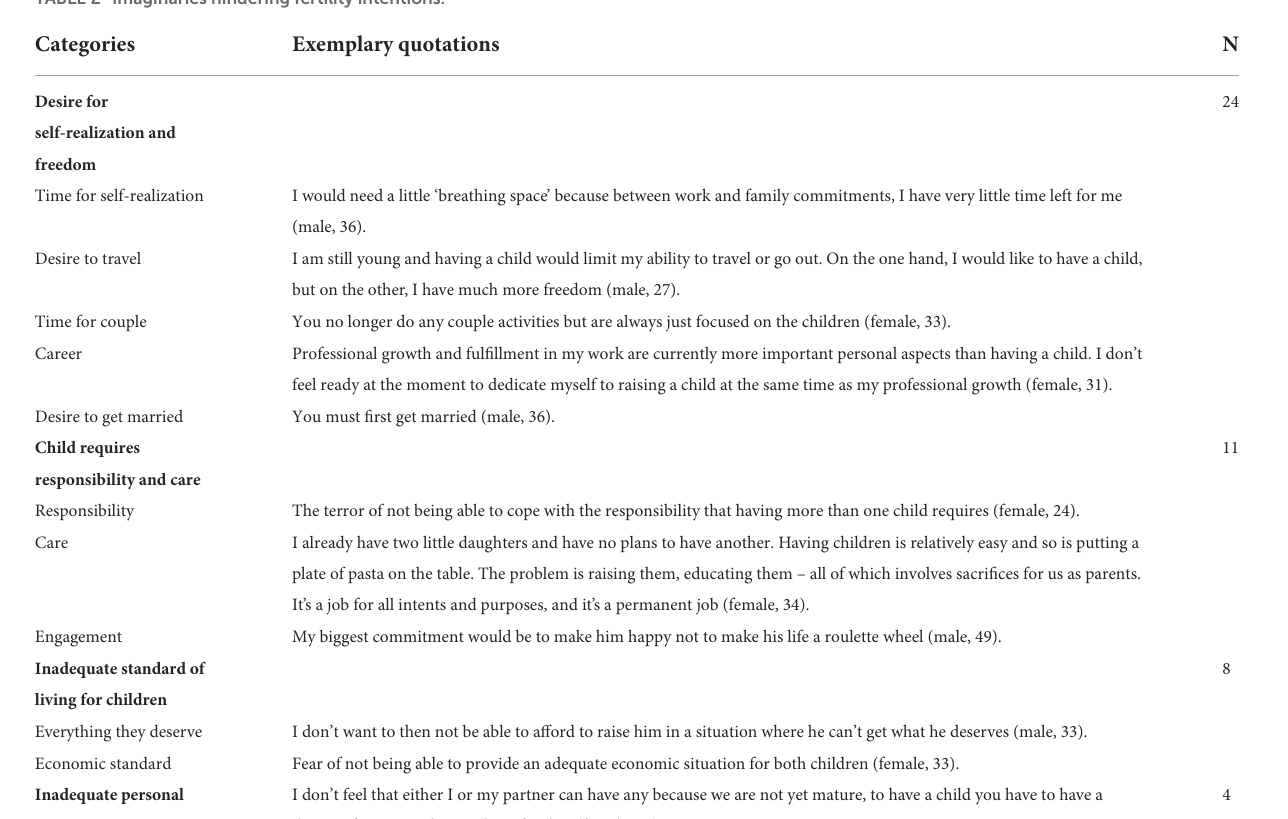
TABLE 2 Imaginaries hindering fertility